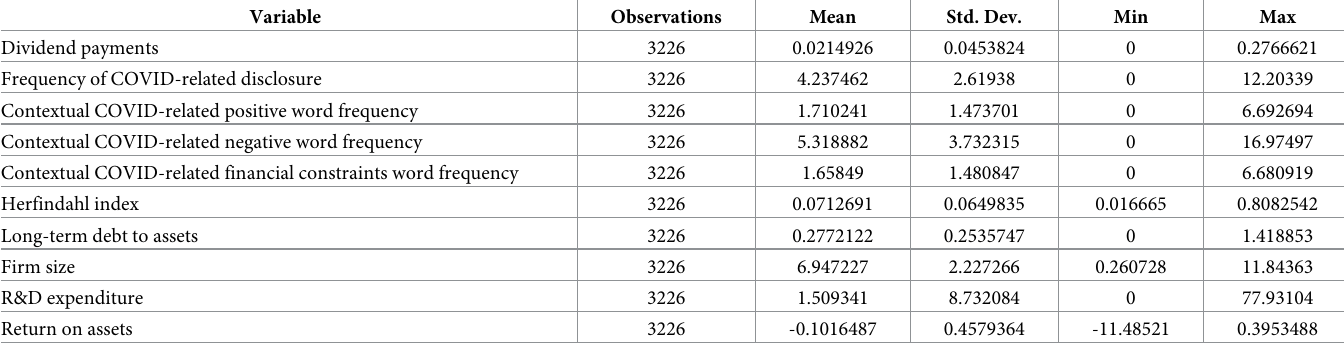
Table 3. Descriptive analysis.